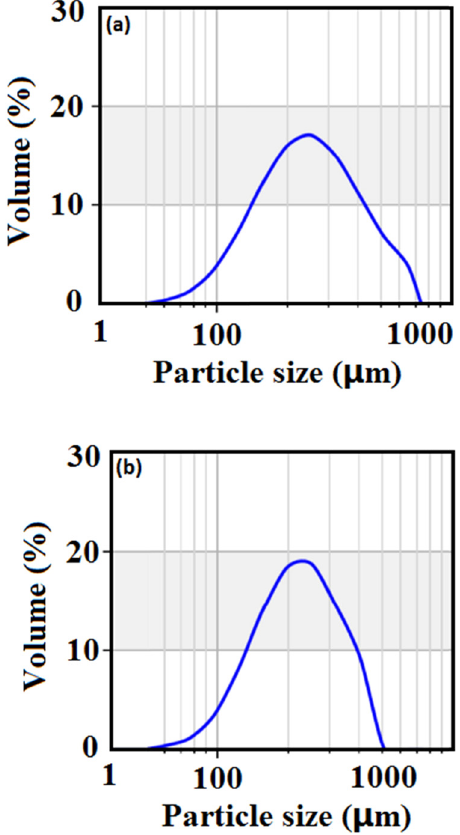
Figure 3: Particle size distribution of ( a ) original samples, ( b ) leached solid samples ( acid leaching conditions – H C O 2 2 4 concen - tration: 10 g/L, HCl concentration: 5%, temperature: 60°C, L/S ratio: 5, time: 8 h, stirring speed: 500 rpm )